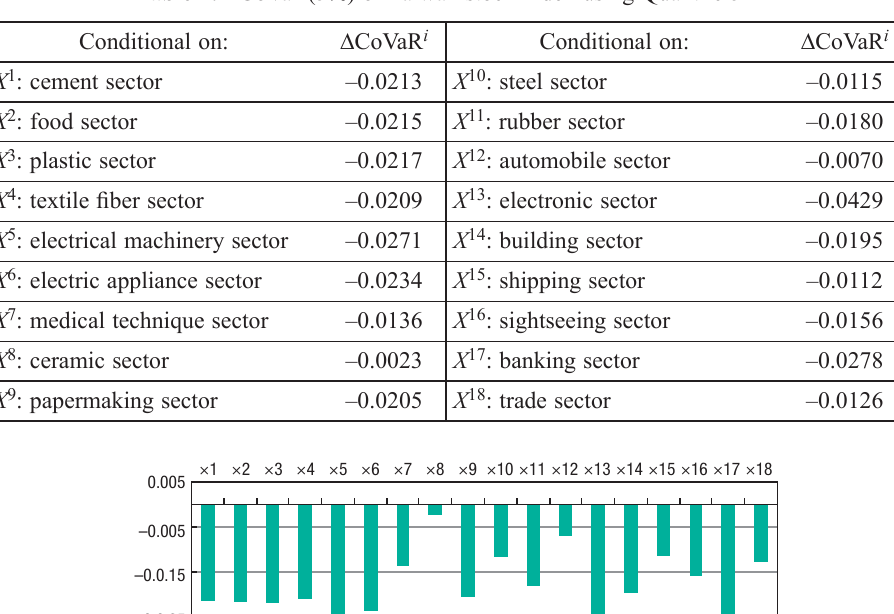
Table 4.  CoVaR(5%) of Taiwan stock index using Quantile 5